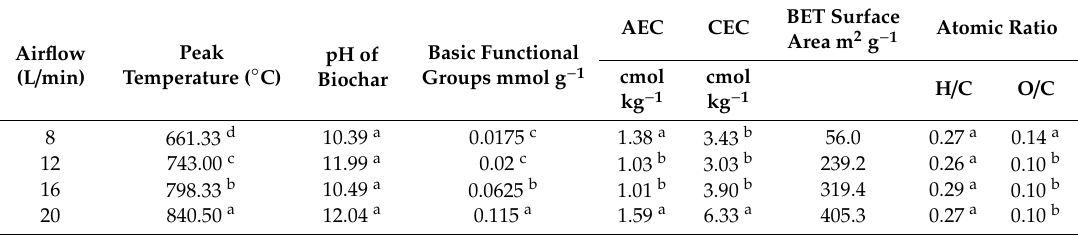
Table 1. Chemical properties of biochar from wood chips at varying airflows (moisture content 10%, average particle size 7 mm, and biomass compactness 0 kg). BET: Brunauer-Emmett-Teller; CEC: Cation Exchange Capacity; AEC: anion exchange